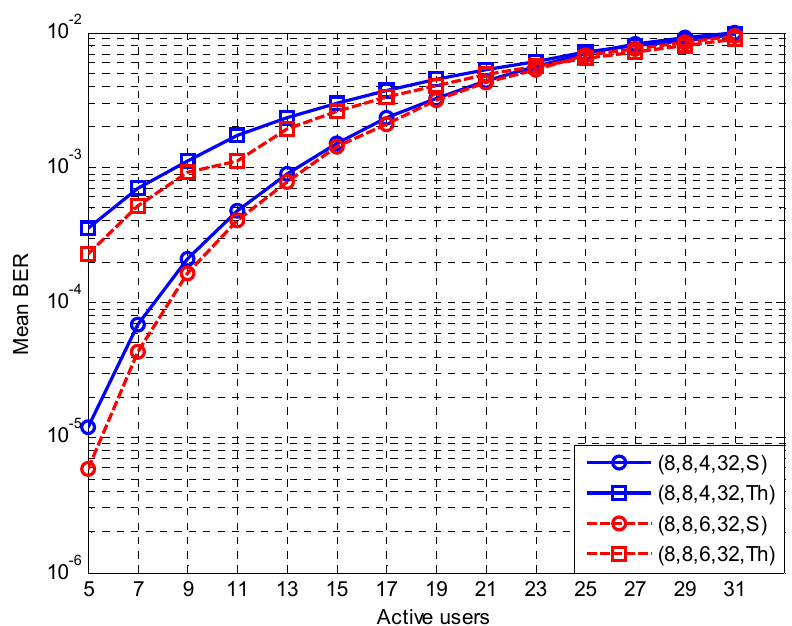
Figure 2. BER values for reduced diversity order MIMO orientations.